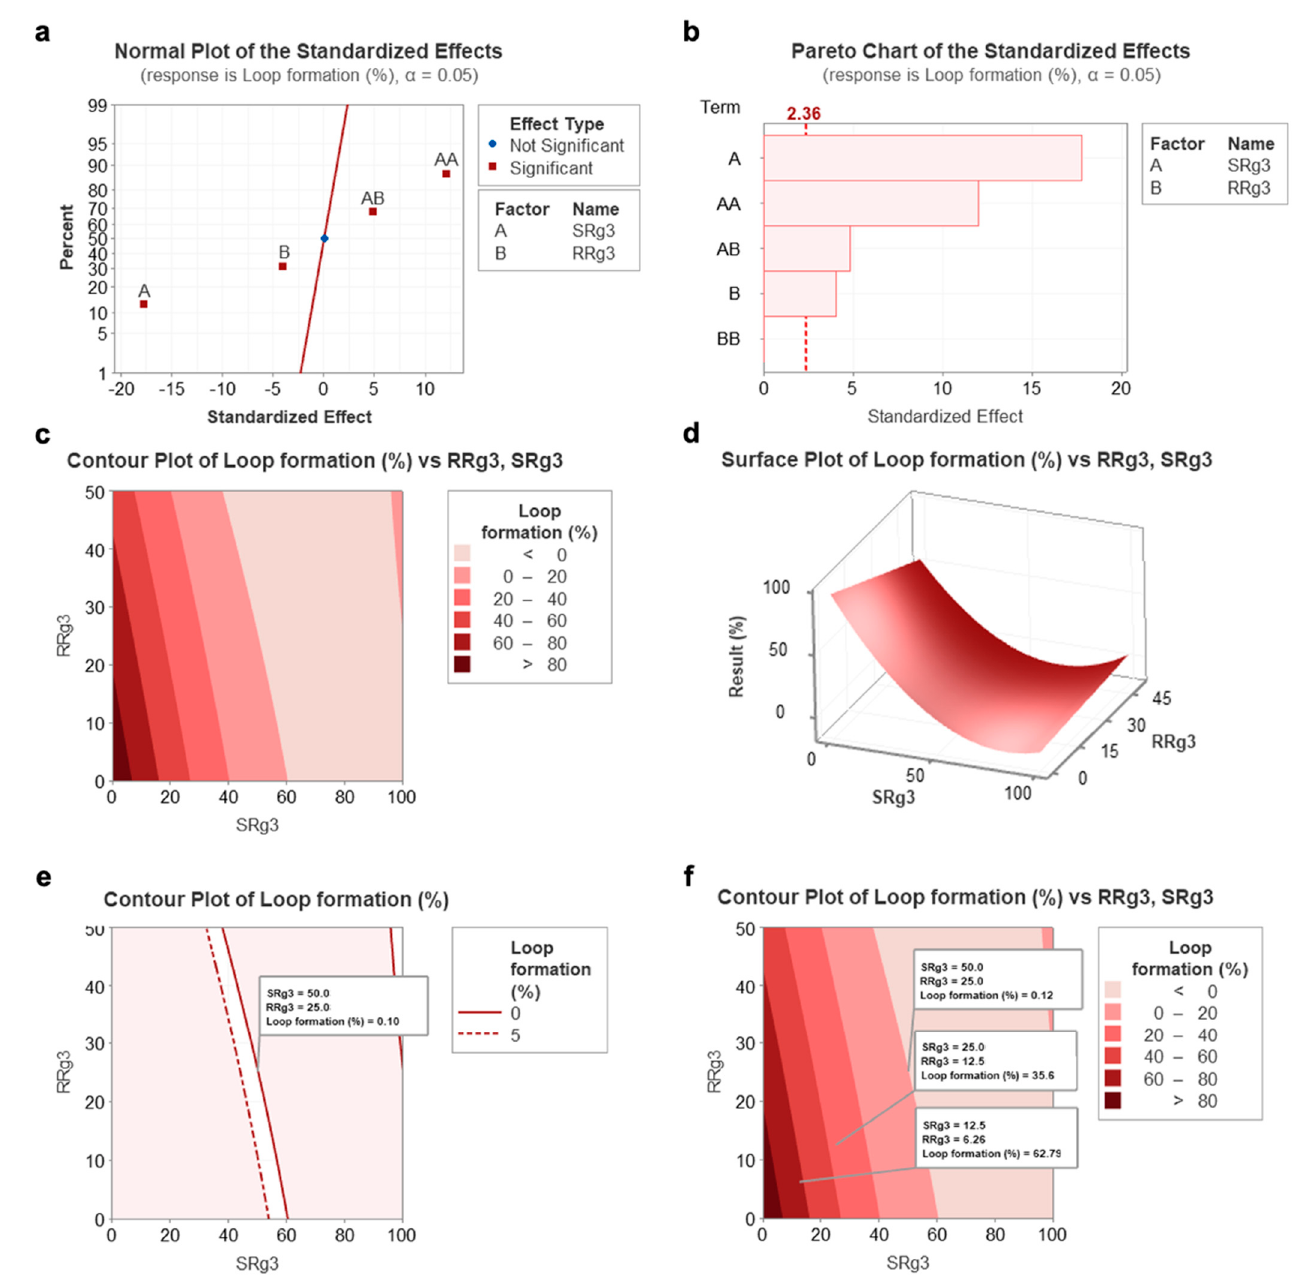
Figure 1. The calculated results of the response surface methodology developed using the central composite design technique for the optimisation of SRg3 and RRg3 drugs. ( a ) Standardised effect chart showing the critical parameters that need to be investigated, ( b ) Pareto chart analysis for loop formation data that reflects the effectiveness of each parameter, ( c ) contour plot, ( d ) surface plot for the percentage of loop formation following a combination of SRg3 or RRg3, ( e ) contour plot highlighting the area with the best efficacy for the combination, and ( f ) contour plot showing the predicted responses of two other combination treatments. A and B stand for SRg3 and RRg3, respectively, and AB represents the combination of SRg3 and RRg3. AA and BB show a mathematical expression of high concentrations of SRg3 and RRg3,